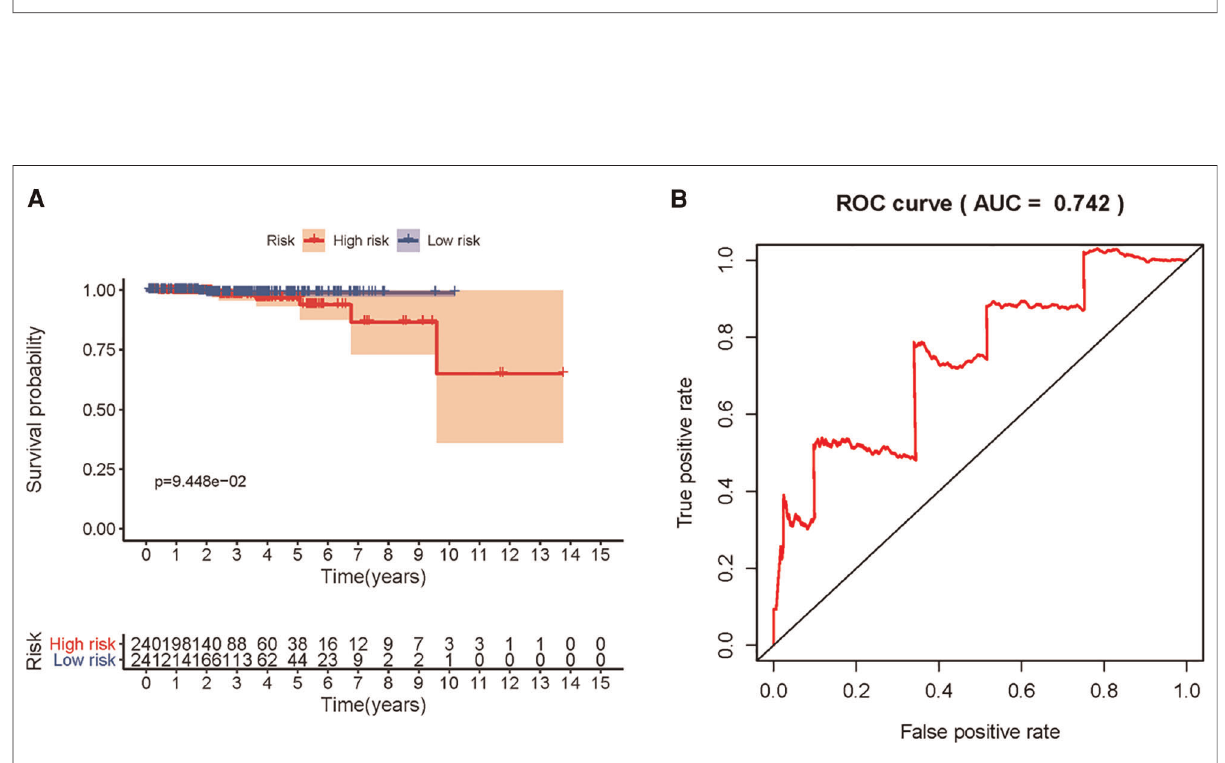
FIGURE 3 Risk score model (RSM) constructed by sDMIRs. risk score distribution in the high-risk group and the low-risk group of PCa patients ( A ). Survival status between the high-risk group and the low-risk group of PCa patients ( B